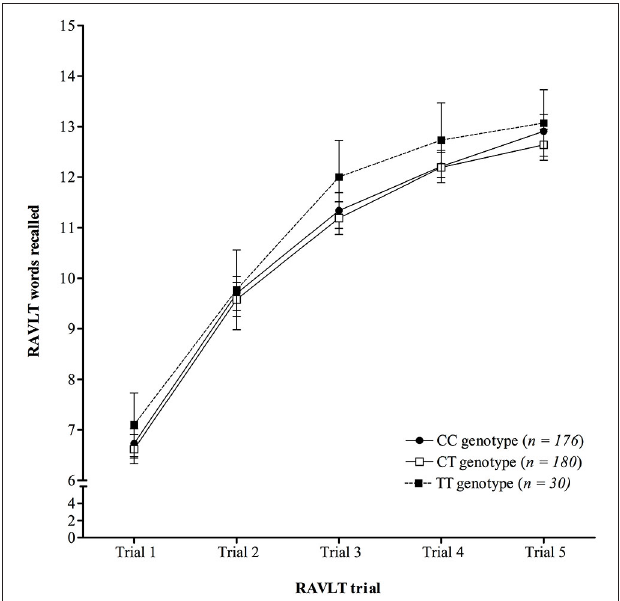
FIGURE 2 | Mean number of total errors made across trials on the PAL test, showing no significant interaction between KIBRA genotype . Error bars display 95% confidence intervals.